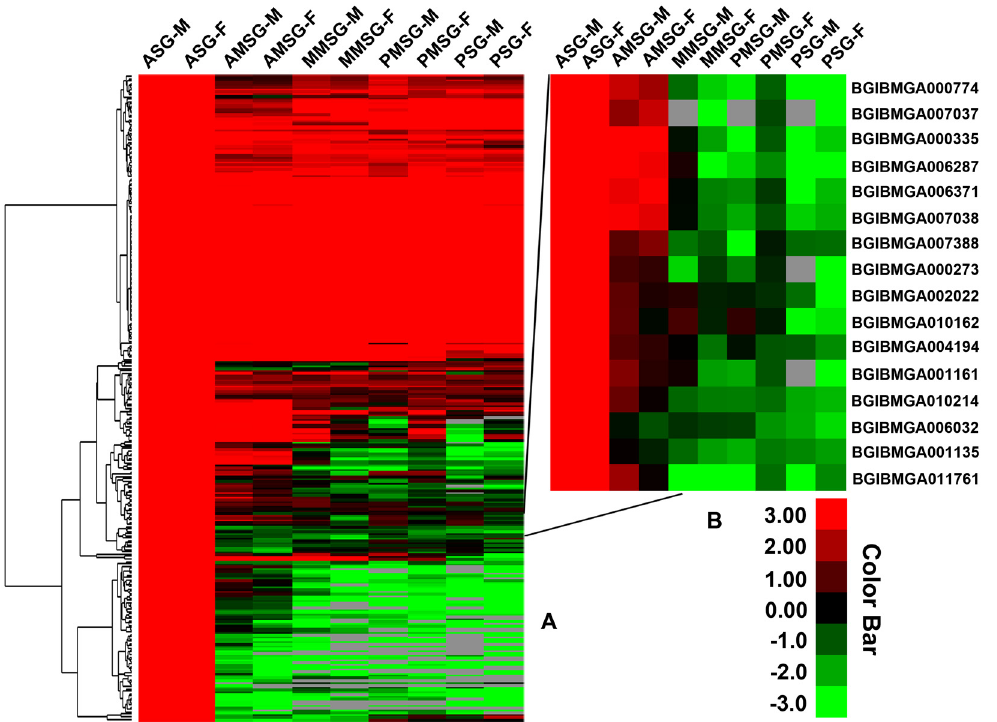
Fig 4. Hierarchical clustering of the up-regulated genes in the ASG vs other parts of the silk gland. (A) The 282 genes up-regulated in the ASG. (B) Example of several clusters, including 16 genes. The red bands indicate genes with high expression levels and the green bands indicate genes with low expression levels.